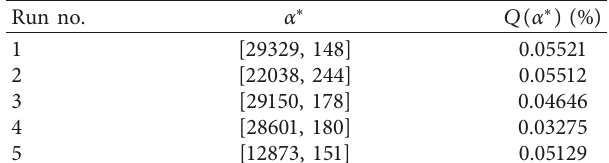
Table 4: GA optimization